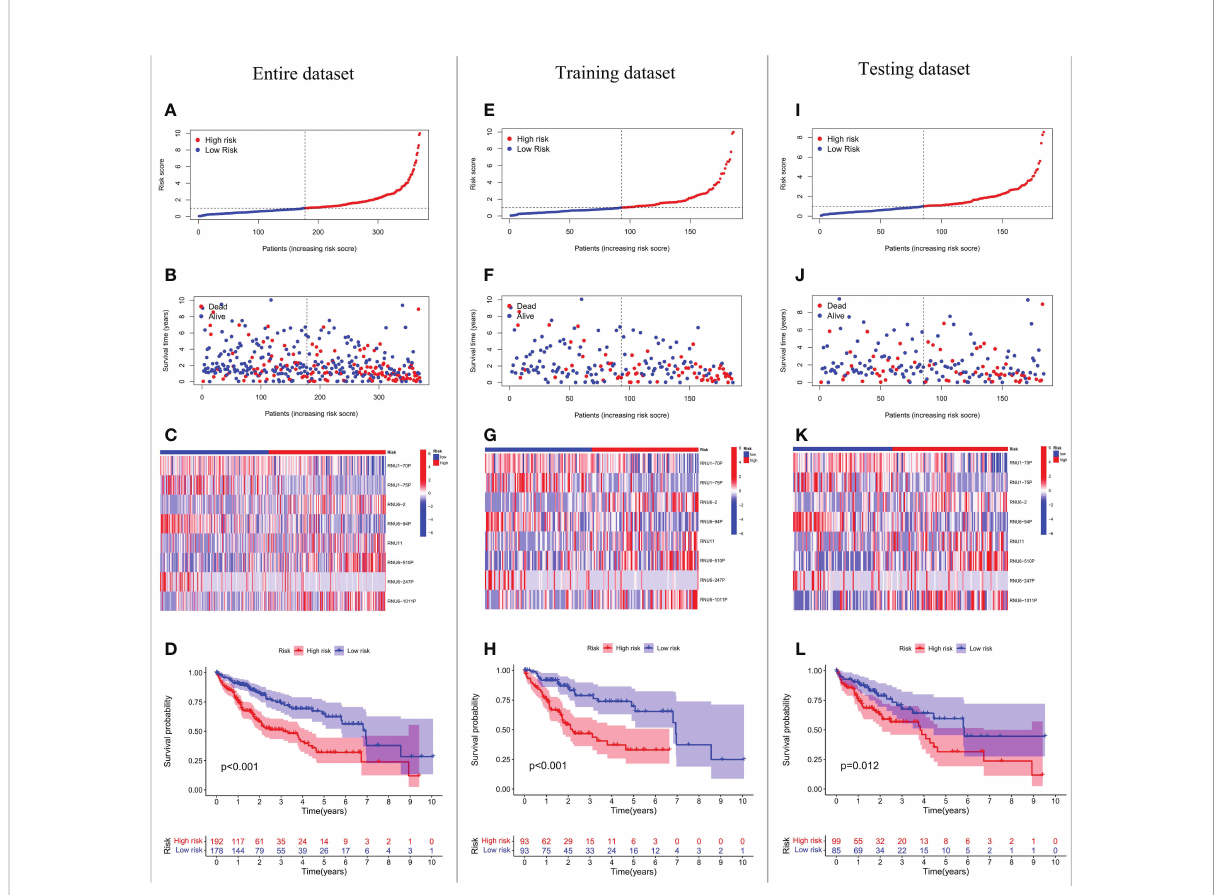
FIGURE 3 Prognostic value of the risk model based on eight m6A-associated snRNAs. Risk score distribution of HCC patients in the entire dataset (A) , the training dataset (E) , and the testing dataset (I) . Distribution of survival status of HCC patients in the entire dataset (B) , the training dataset (F) , and the testing dataset (J) . Heatmap of prognostic m6A-associated snRNA expression in HCC patients in the entire dataset (C) , the training dataset (G) , and the testing dataset (K) . OS of HCC patients based on risk scores in the entire dataset (D) , the training dataset (H) , and the testing dataset (L)